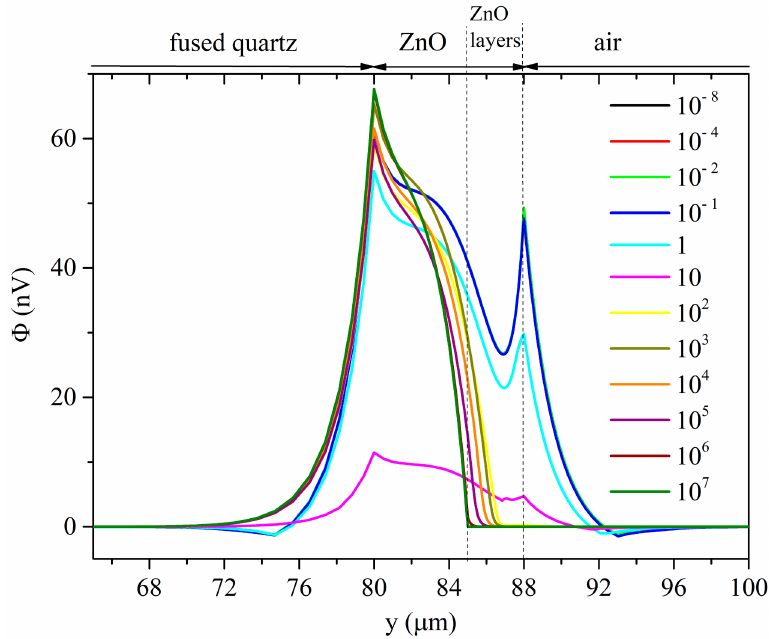
Figure 15. The electric potential distribution under the Rayleigh mode at some conductivity values, under top illumination, and under δ UV = 200 nm.